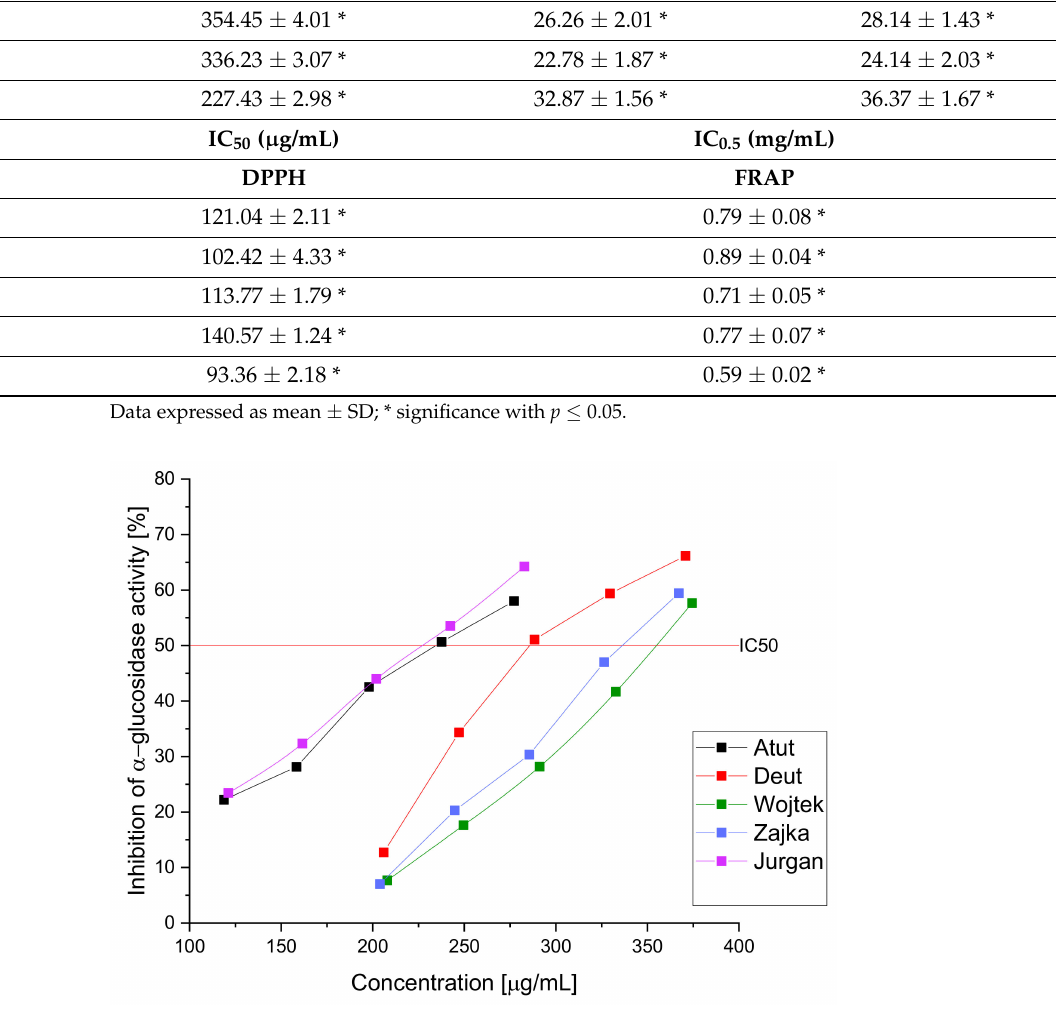
Figure 1. Inhibition of α -glucosidase activity by aqueous extracts of haskap berry